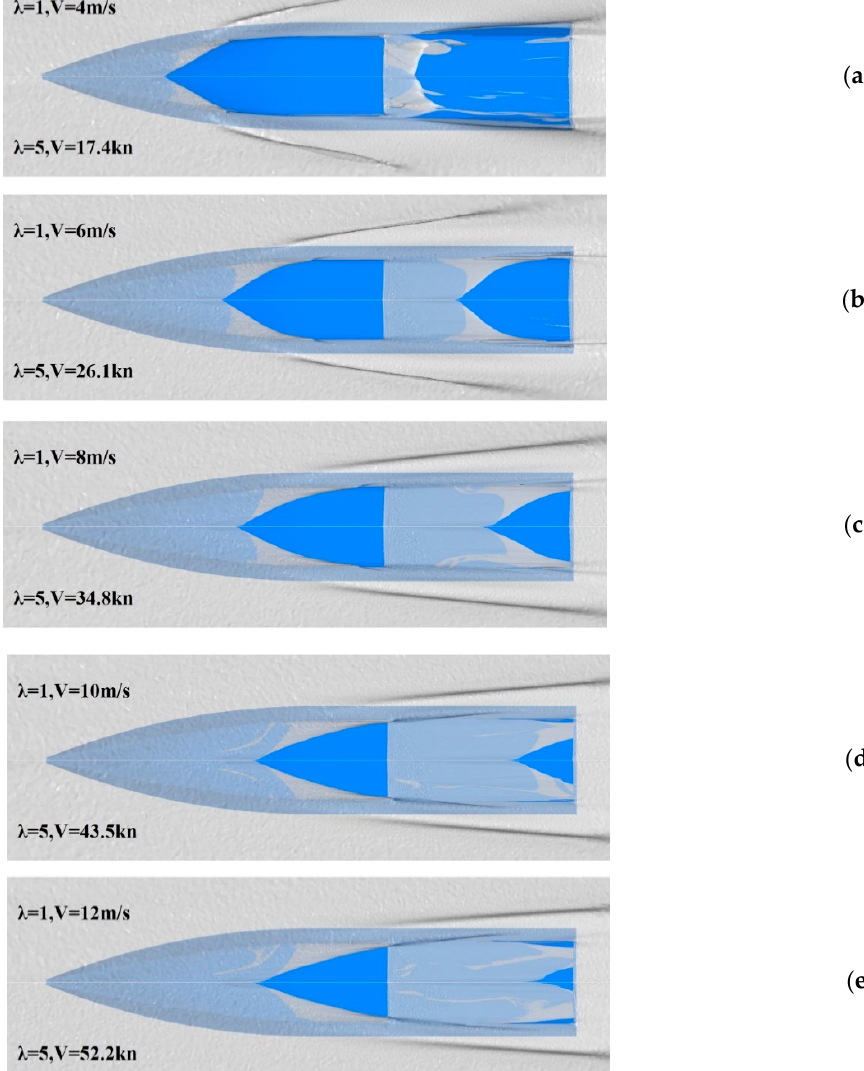
Figure 10. Bottom view of wave characteristics of stepped planing hull in both model and full-scaled boat: ( a ) Fr ∇ = 2.29; ( b ) Fr ∇ = 3.34; ( c ) Fr ∇ = 4..58; ( d ) Fr ∇ = 5.73; ( e ) Fr ∇ = 6.87 .